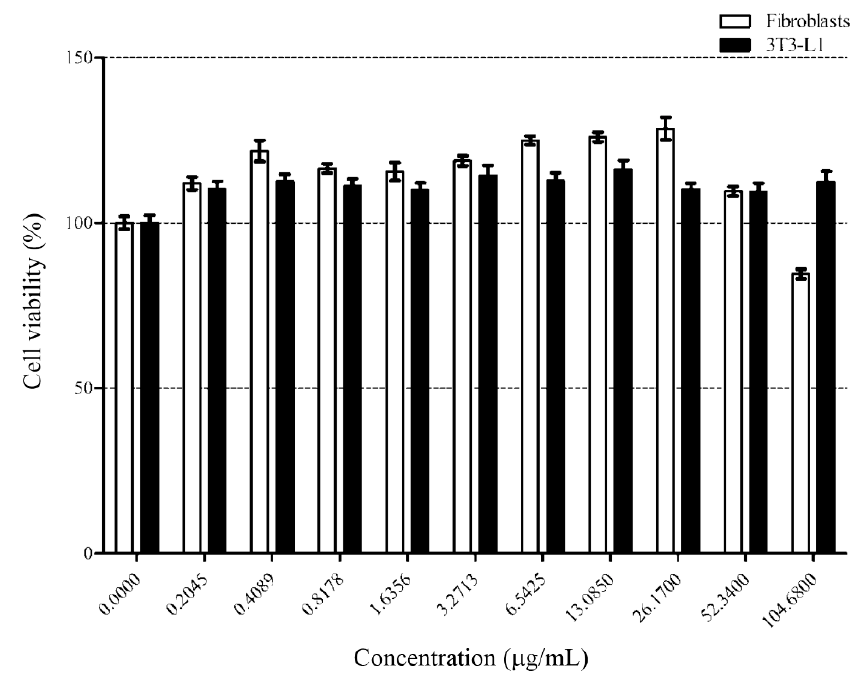
Figure 2. Fibroblast and differentiated adipocyte cells were treated with increasing concentration of loaded liposomes for 24 h. % cell viability was measured by MTT assay. Symbols, ( ■ ) and ( ☐ ), represent the differentiated 3T3-L1 cells and fibroblast cells, respectively. y -axis represents the percentage of cell viability and x -axis represents concentrations of the loaded liposome. Data are shown as the mean ± SD from triplicate results.